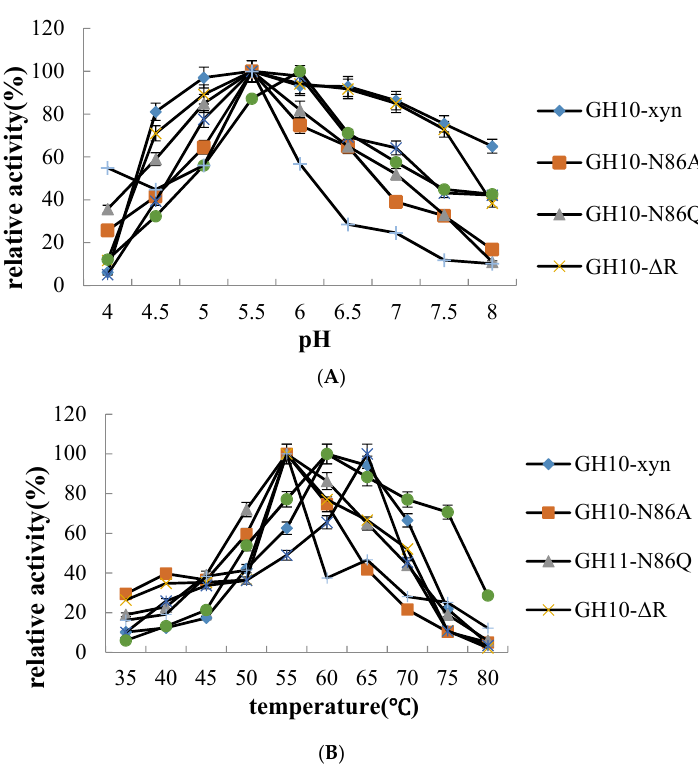
Figure 5. The properties of GH10/11-xyn and mutants with beechwood xylan substrate ( A ) optimal pH and ( B ) Optimal temperature. The best xylanase activity defined as 100%.